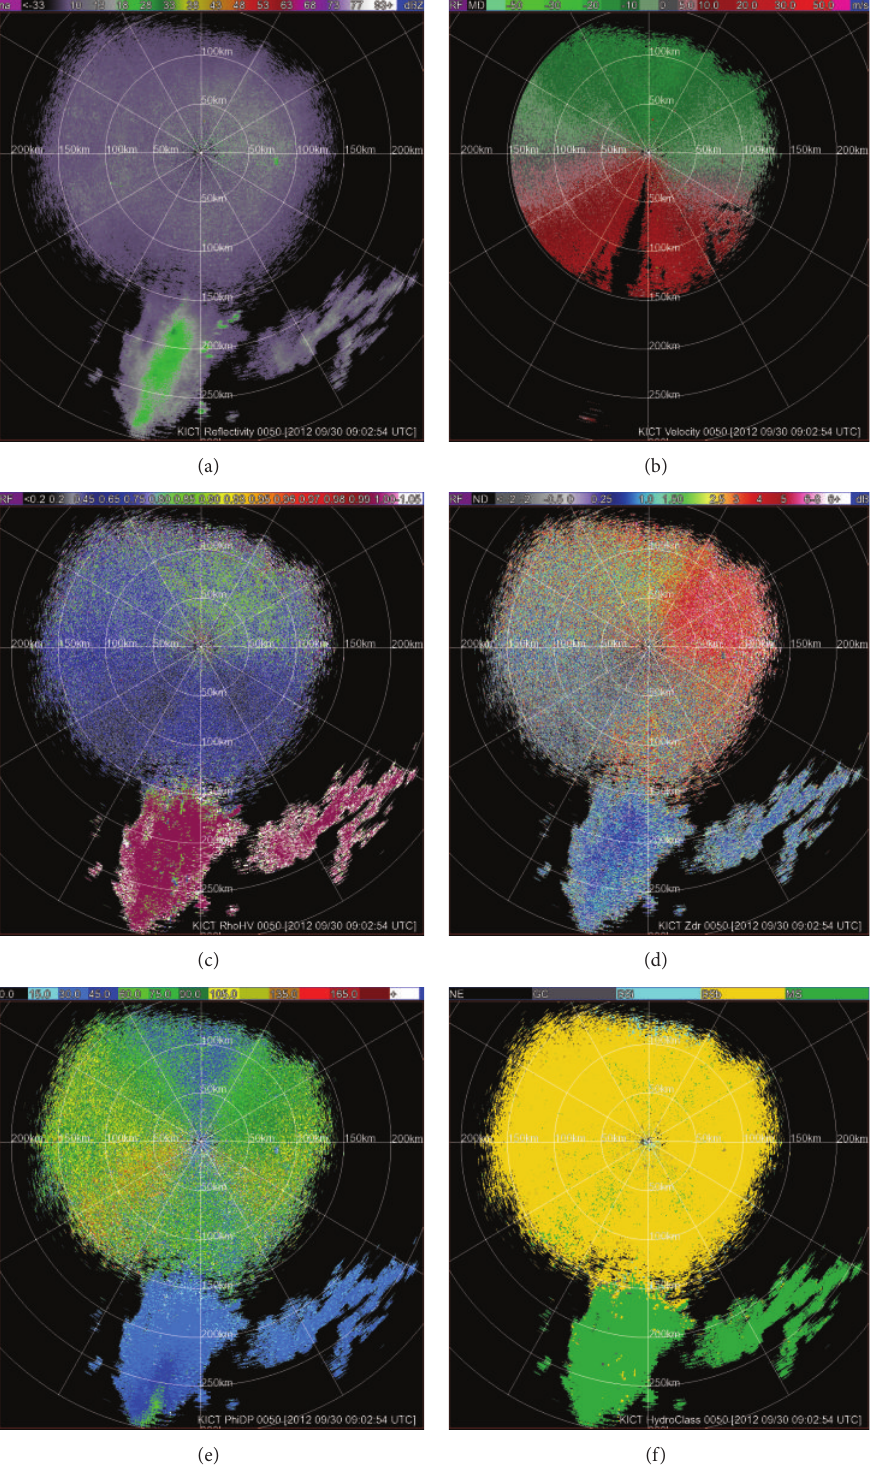
Figure 6: Images of (a) 𝑍 , (b) V 𝑟 , (c) 𝜌 scan at 090142 UTC (local time around 4am) on 30 September 2012. The spatial resolutions of the original data are the same as in Figure